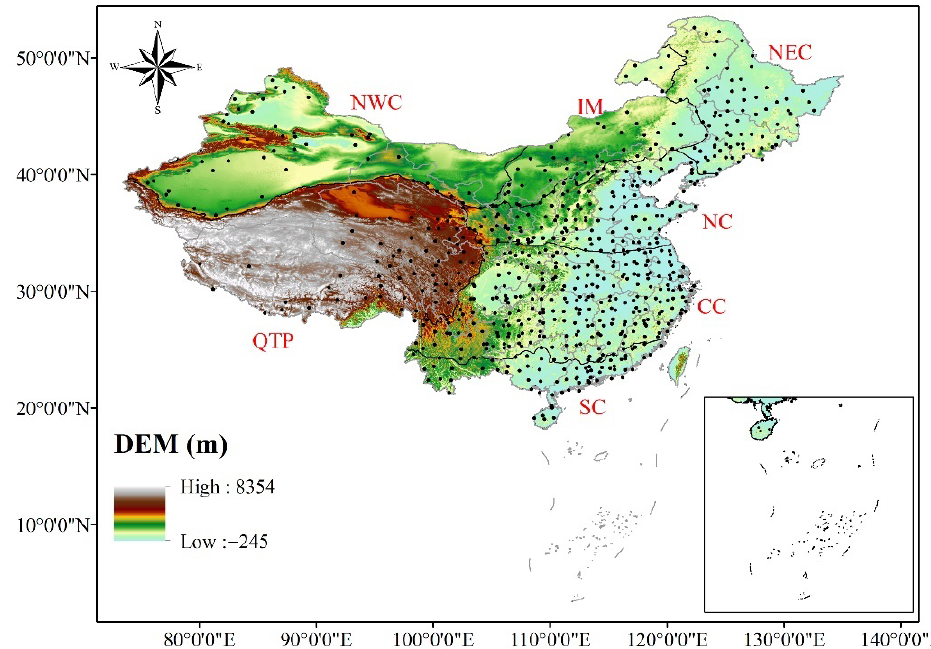
Figure 1. The geographical distribution of meteorological stations used in this study.